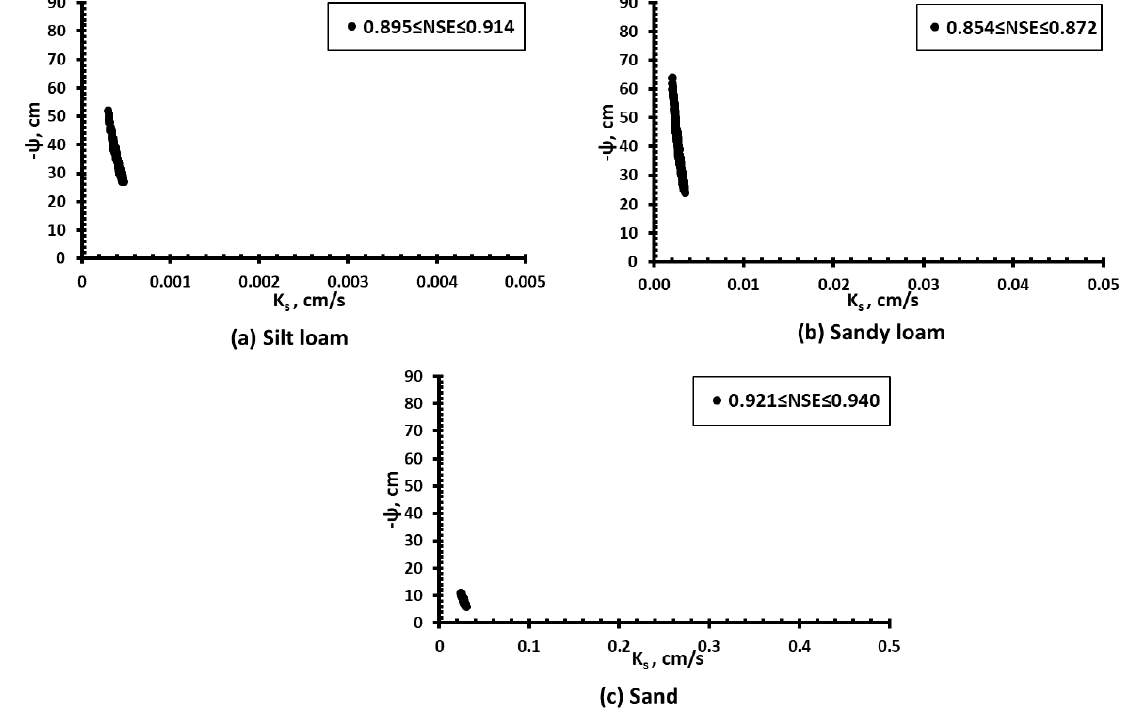
Figure 8. The successful sets of parameters K s versus - Ψ (delineated by NSE ≥ the threshold value) determined from simulation using ∆ H s determined by Equation (5) and the changes in measured head ∆ H . ( a ) silt loam, ( b ) sandy loam, and ( c ) sand. Note: The limits for K s (or x-axis) are di ff erent for the three soils.